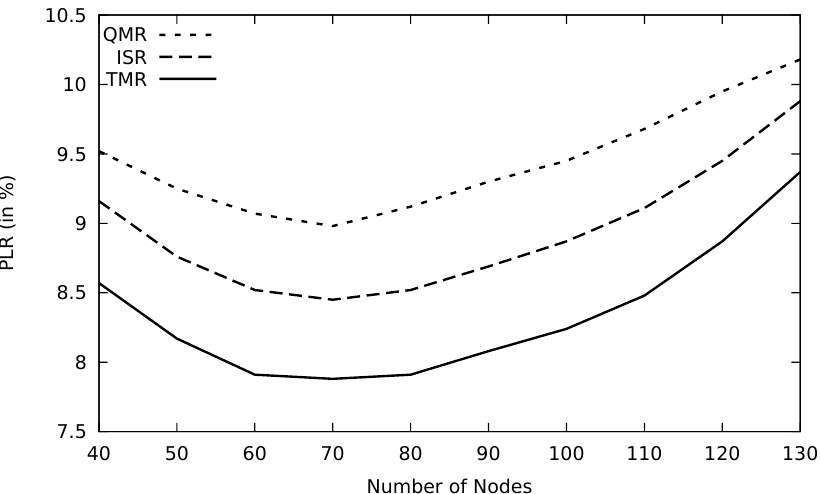
Figure 33. Comparison of QMR, ISR, and proposed protocol TMR for PLR with number of nodes.